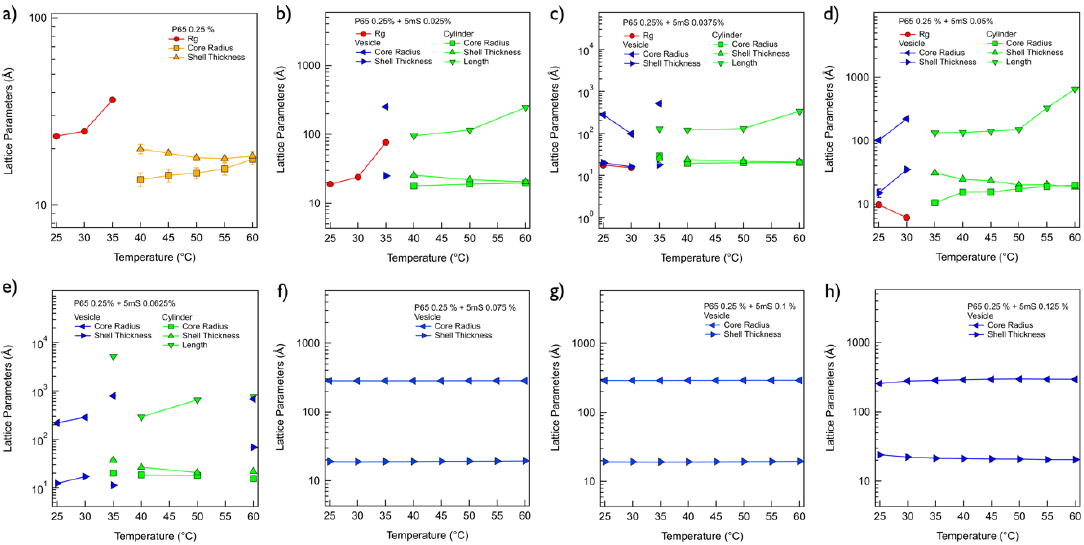
Figure 3. Fitting parameters obtained from the small angle neutron scattering (SANS) analyses of P65 (0.25%)-5mS ( a ) 0%, ( b ) 0.025%, ( c ) 0.0375%, ( d ) 0.05%, ( e ) 0.0625%, ( f ) 0.075%, ( g ) 0.1%, and ( h ) 0.125% mixtures.